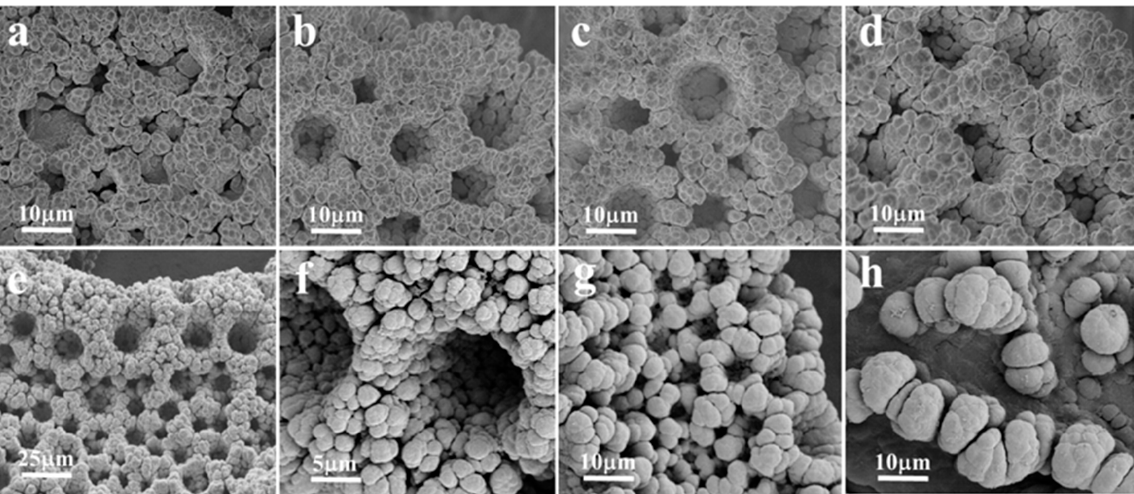
Figure 3. SEM images of the pNF prepared at 1.0 A cm − 2 for di ff erent electrodeposition times. ( a ) 20 s, ( b ) 30 s, ( c ) 40 s, ( d ) 50 s, ( e , f ) 60 s, ( g ) 70 s, ( h ) 80 s.